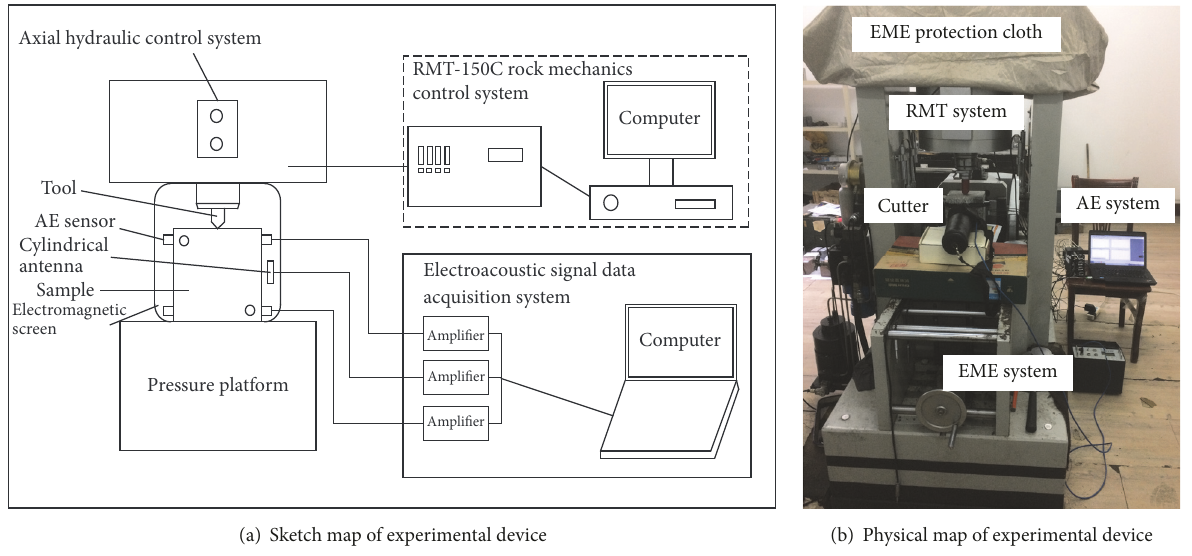
Figure 1: Diagram of test equipment.